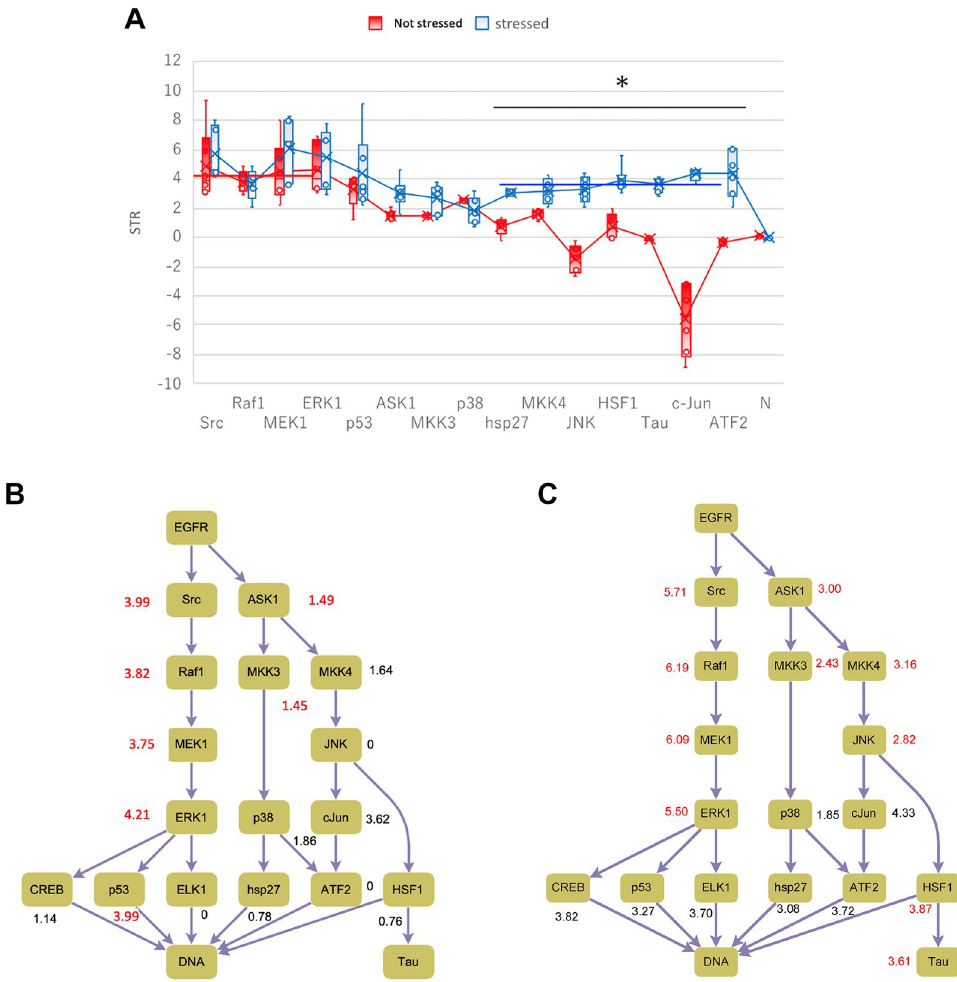
Figure 2. Signal transduction rate (STR) values in non-stressed and stressed cells. MAPK signal cascade in A431 cells. ( A ) Box plots of EGFR-related signaling molecules. The vertical axis represents the STR (min −1 ; n = 5 or 6 per protein). N represents the negative control using a value of the array without antibody binding. The horizontal line with the asterisk indicates significant differences between non-stressed and stressed cells (* p < 0.01, in hsp27, MKK4, HSF1, Tau, c-Jun for non-stressed vs. stressed cells). ( B ) & ( C ) Schematics of the signaling cascades during stress. ( B ) represents the non-stressed state, and ( C ) represents the stressed state. The numbers in red represent the STRs in the working cascades (| σ j | ≤ 0.3). HSF1 heat shock transcription factor 1, hsp27 heat shock protein 27 34,35 , ATF2 activating transcription factor 2, MKK3/4 mitogen activated protein kinase 3/4, JNK c-Jun N-terminal